Question: Does the plotted quantity increase or decrease?
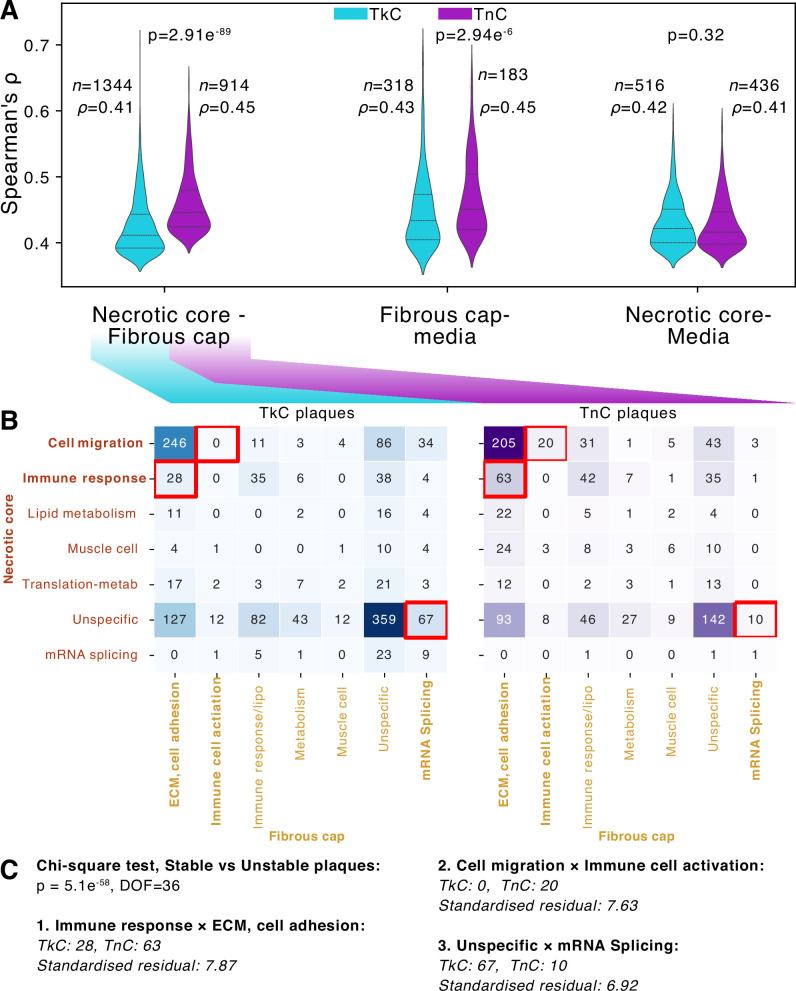
Answer: increasing